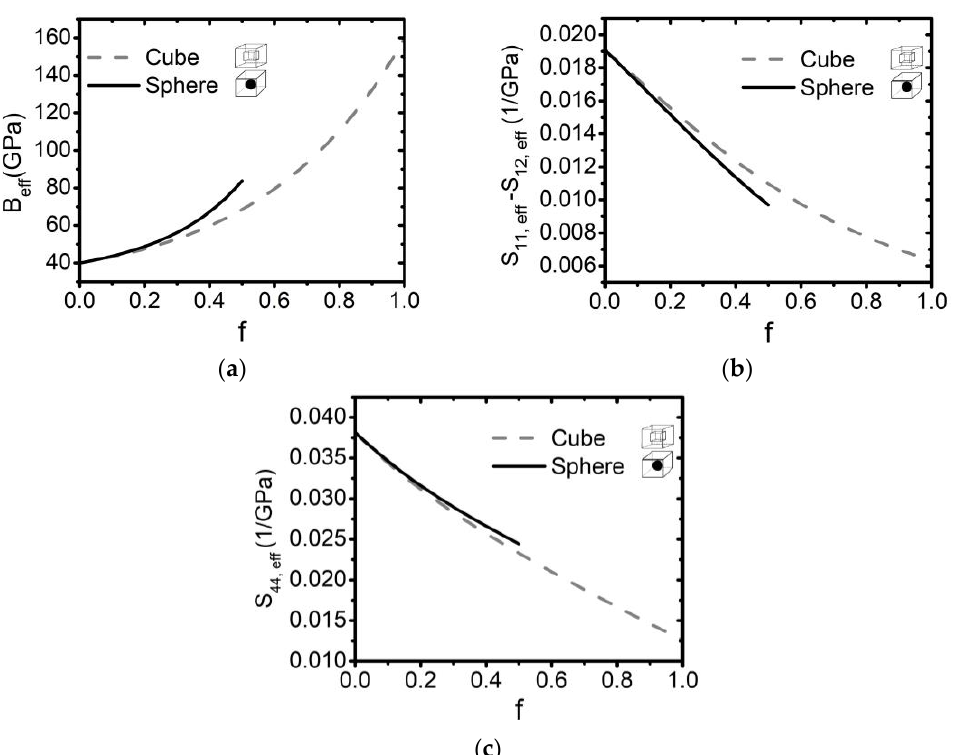
Figure 4. Effective parameters as a function of the filling fraction of a solid-solid 3D phononic crystal for a cubic matrix of glass with cubic and spherical inclusions of steel: ( a ) B eff ; ( b ) S 11 ,eff – S 12 ,eff, and ( c ) S 44 ,eff .